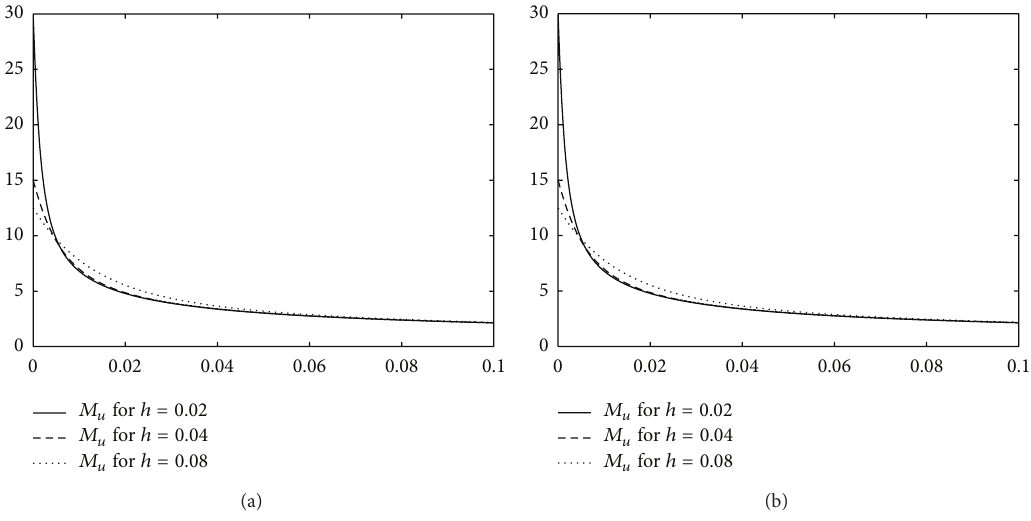
Figure 4: Experimental values of Lipschitz constants 𝑀 𝑢 (𝑡) and 𝑀 V (𝑡) for ℎ = .002 , ℎ = .004 , and ℎ = .008 .